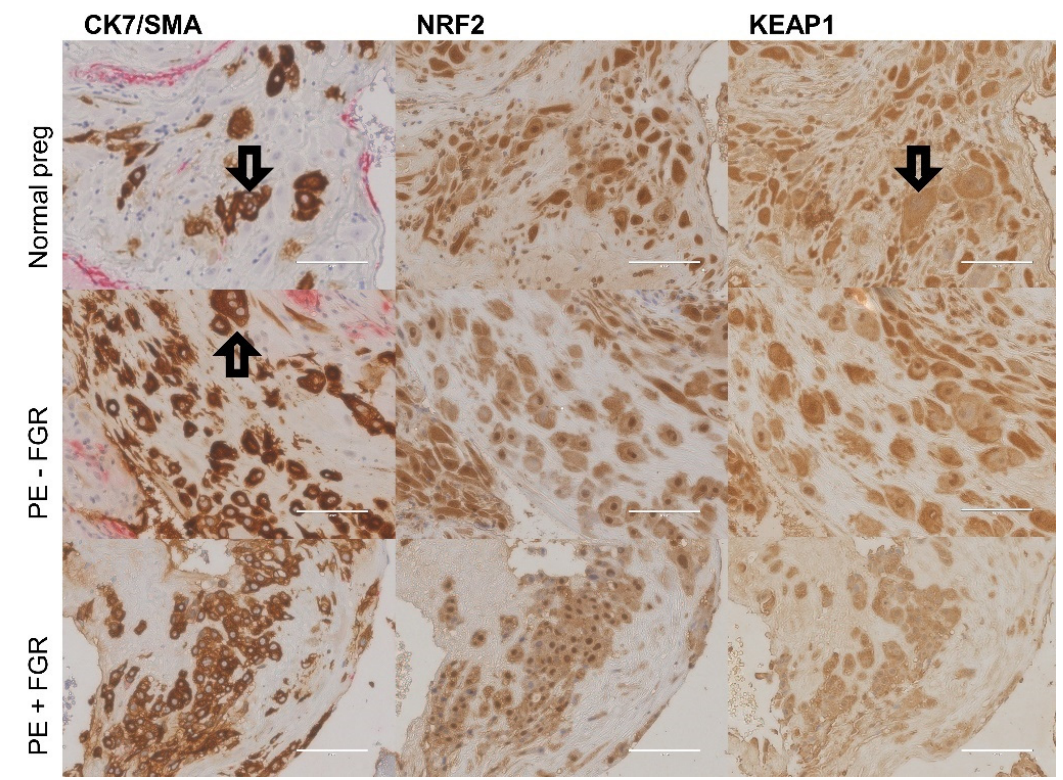
Figure 3. Decidual expression of trophoblasts (cytokeratin 7 (CK7)), nuclear factor erythroid 2-related factor 2 (NRF2), and Kelch-like ECH-associated protein 1 (KEAP1) in normal pregnancy, preeclampsia (PE) without fetal growth restriction (FGR), and PE with FGR (40× magnification). CK7 was counterstained with smooth muscle actin (SMA). The transparent arrows indicate examples of trophoblast giant cells. Scale bar: 100 µ M.